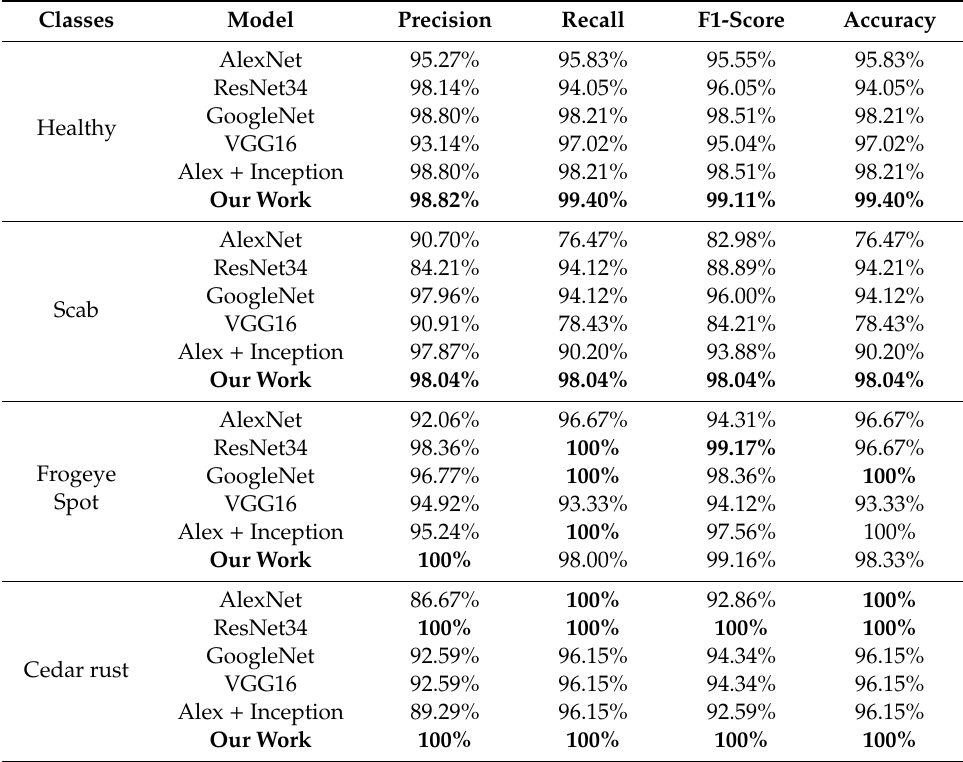
Table 3. Classification performance comparison among di ff erent models.